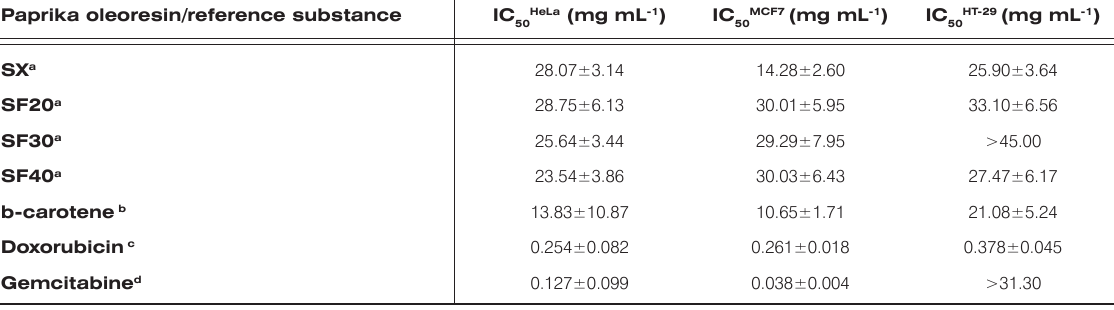
Table 2. IC values of SX, SF20, SF30, SF40 paprika oleoresins and reference substances in human tumor cell lines. 50 Paprika oleoresin/reference